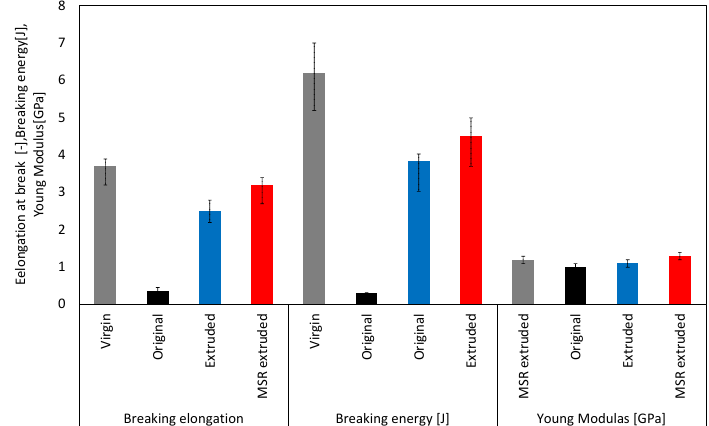
Figure 5. Elongation at break values, Young’s moduli, and breaking energies of the moldings calculated from the tensile stress–strain curves (in each block, from left to right, the data for the virgin, original, extruded, and molten resin reservoir (MSR)-extruded pellet moldings are shown in grey, black, blue, and red, respectively).